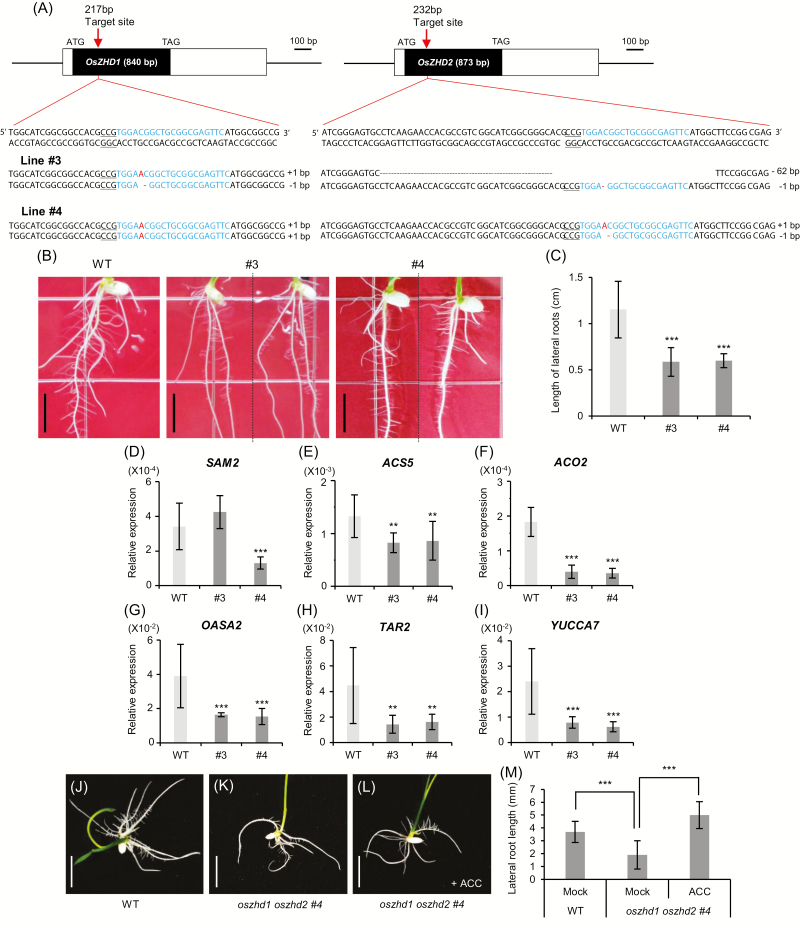
Analysis of oszhd1 oszhd2 double mutants. (A) Schematic diagram of OsZHD1 and OsZHD2 genes and the mutation sites created using the CRISPR/Cas9 system. (B) Phenotypes of oszhd1 oszhd2 double mutants compared with the WT at 6 DAG. (C) Lengths of lateral roots at 6 DAG. n>40. Error bars show the SD. Statistical significance is indicated by *** (P<0.001). (D–F) Transcript levels of ethylene biosynthesis genes, SAM2 (D), ACS5 (E), and ACO3 (F) in root samples at 4 DAG. n=4. (G–I) Transcript levels of auxin biosynthesis genes, OASA2 (G), TAR2 (H), and YUCCA7 (I) in root samples at 4 DAG. For normalization, rice ubiquitin 1 (Ubi1) served as an internal control. n=4. Statistical significance is indicated by ** (P<0.01) or *** (P<0.001). (J–L) Phenotypes of the WT (J) and oszhd1 oszhd2 #4 without (K) and with 1 µM ACC treatment (L) at 5 DAG. M, lengths of lateral roots of WT and oszhd1 oszhd2 plants. n>20. Error bars show the SD. Statistical significance is indicated by *** (P<0.001).